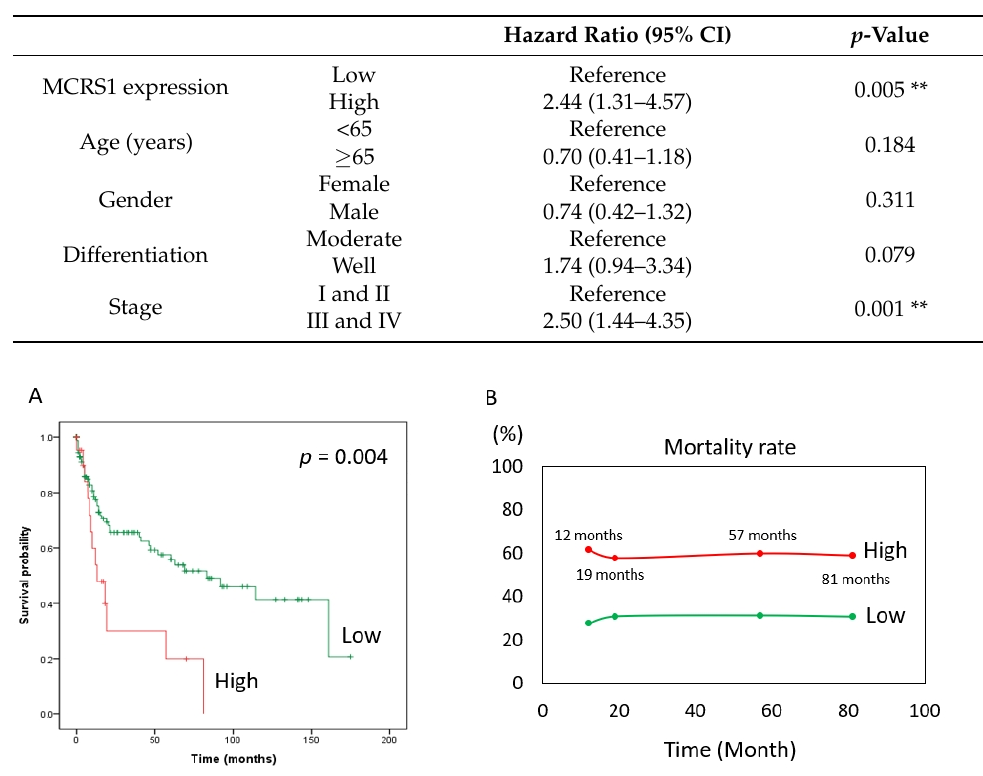
Figure 1. Differences in H-score of MCRS1 according to different categories. ( A ) Age; ( B ) Gender; ( C ) Tissue type; ( D ) Degree of differentiation; ( E ) Disease stage. *** p -value < 0.001. Table 4. Hazard ratios of MCSR1. (** p -Value < 0.01).